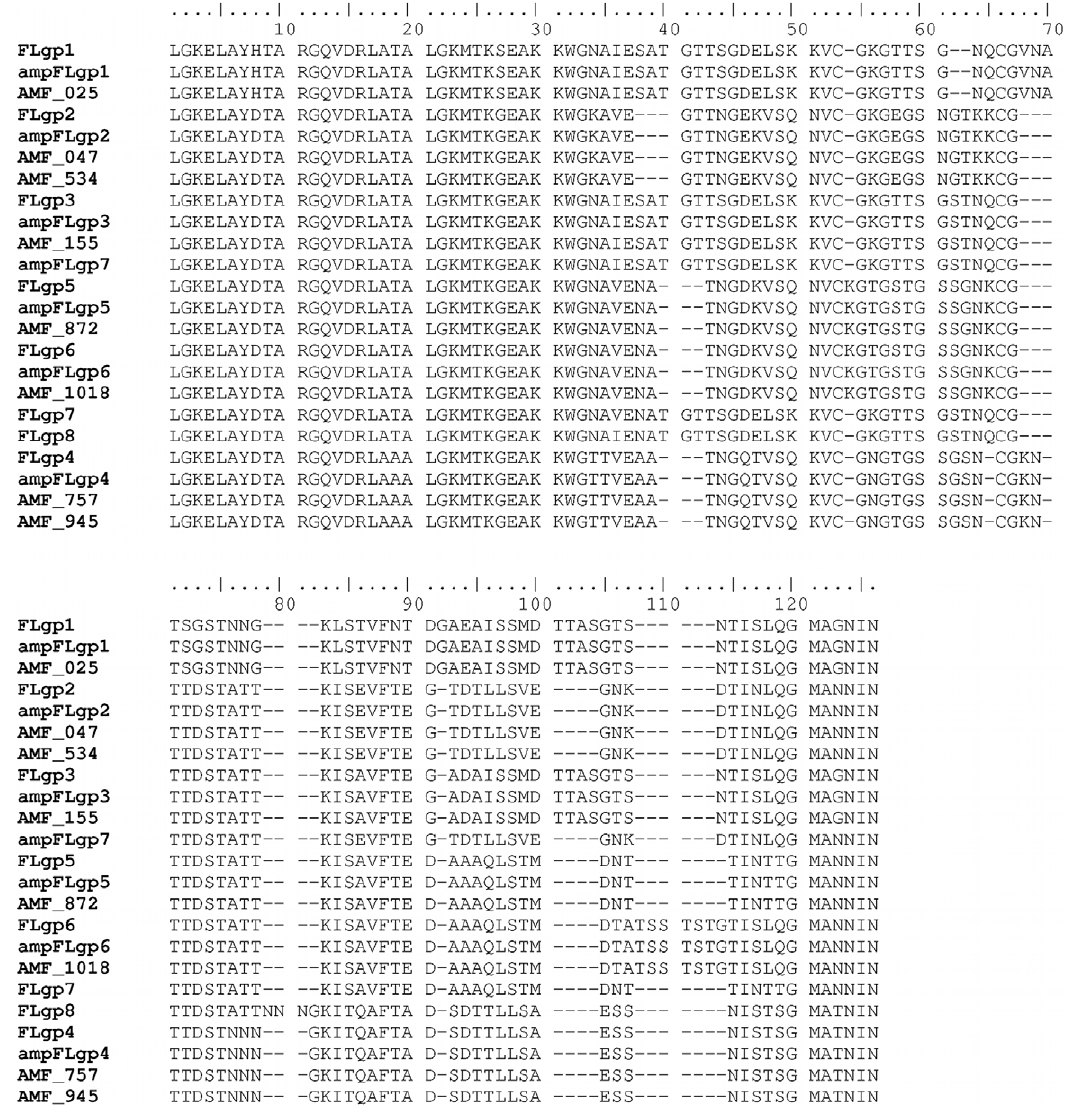
Figure 4. Alignment of all pseudogene sequences from amplified and nonamplified genomic DNA sequences extracted from the Florida strain with full-length pseudogenes from the previously sequenced Florida strain (CP001079).